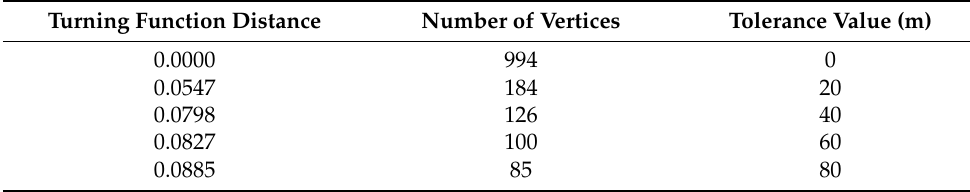
Table 5. Computation of turning function distances per tolerance value, (line